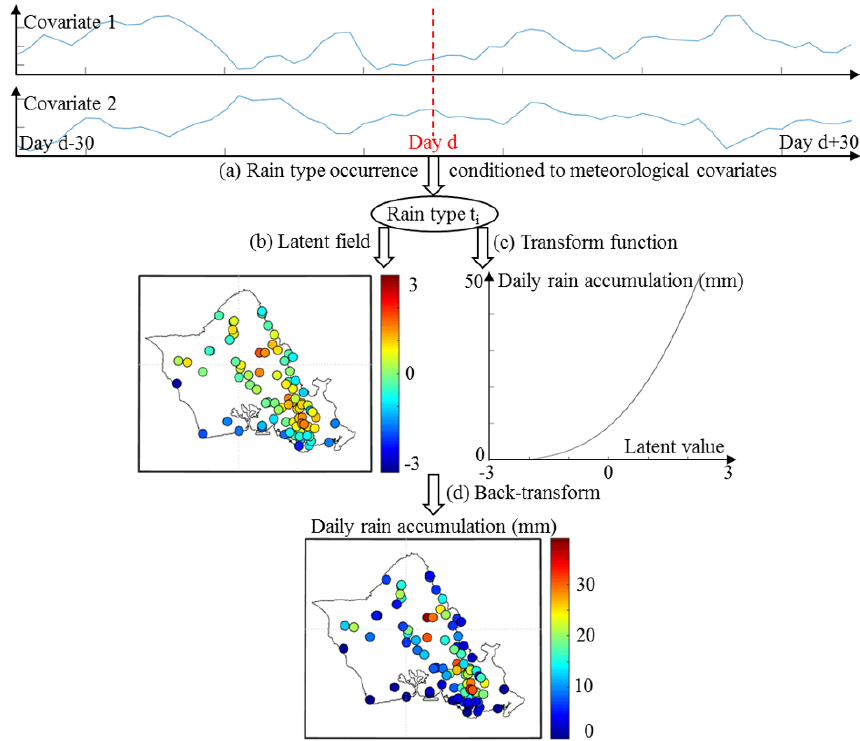
Figure 2. Overview of the structure of the stochastic rainfall model. (a) Meteorological covariates (here geopotential at 950hPa and tem- perature difference between 950 and 700hPa) driving the occurrence of rain types, which summarize daily rain statistics. (b) Latent field modeling of the spatial distribution of rainfall across the island. (c) Transform function linking latent values with actual rain accumulations. (d) Back-transform combining (b) and (c) to obtain daily rain